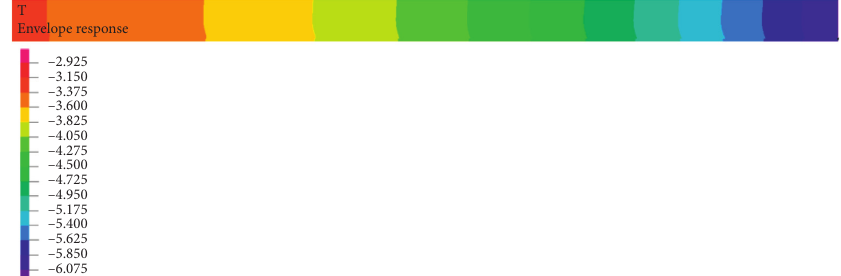
Figure 31: Annual average air temperature distribution in the tunnel axis at an air velocity of 3.5